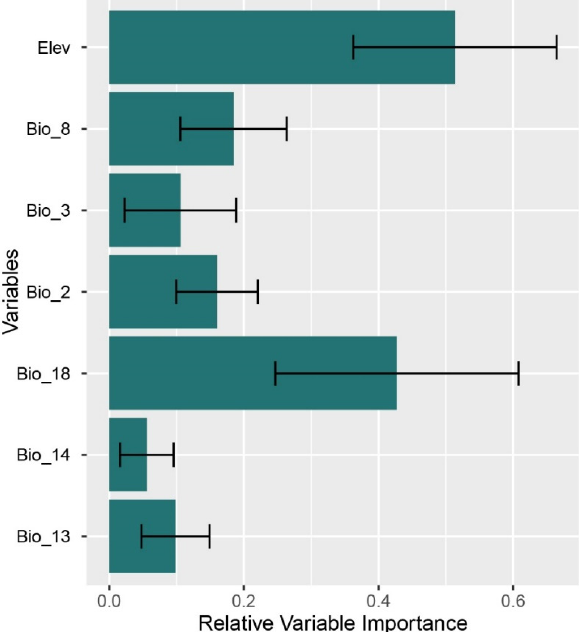
Figure 5. Relative variable importance for the species distribution models of Platycnemis subdilatata in North Africa based on 11 different algorithms and the test-dependent dataset. Bio2: mean diurnal range, Bio3: isothermality, BIO8: mean temperature of wettest quarter, Bio13: precipitation of wettest month, Bio14: precipitation of driest month, Bio18: precipitation of warmest quarter, Elev: elevation. More details in Table S2.